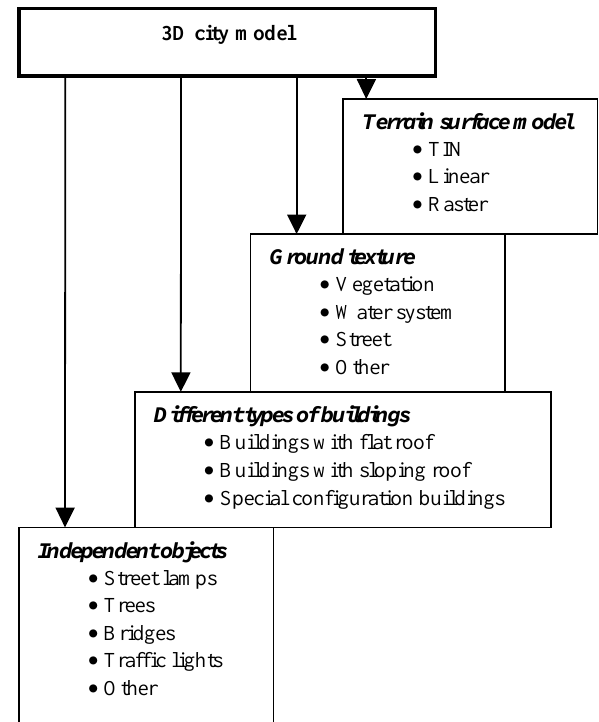
Fig 2 . The chart of graphical elements of the